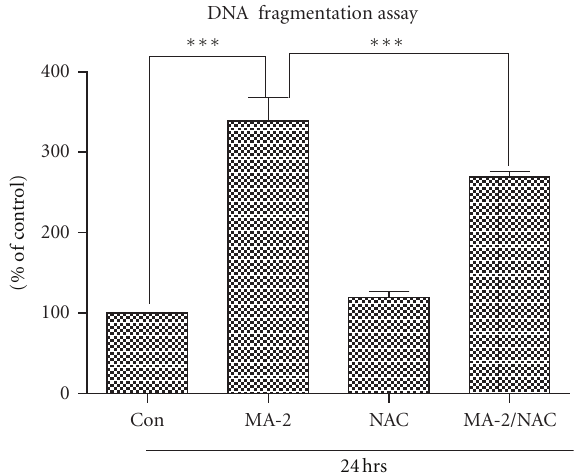
Figure 5: E ff ect of NAC on MA-induced apoptotic cell death in N27 cells. Cells were pretreated with 5mM NAC for 1 hour followed by treatment with MA (2mM) or PBS for 24 hours. DNA fragmentation was quantified using a cell death detection using Roche Elisa PLUS kit. The data are expressed as percentage of DNA fragmentation compared with untreated control cells, and asterisks ( ∗∗∗ P < 0 . 01) indicate significant di ff erences between untreated control group with MA-treated group and MA-treated group with NAC group with MA